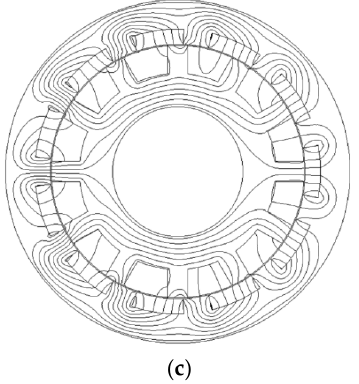
Figure 5. Magnetic field distributions: ( a ) IR-VPM; ( b ) OR-VPM and ( c ) OR-CP-VPM.